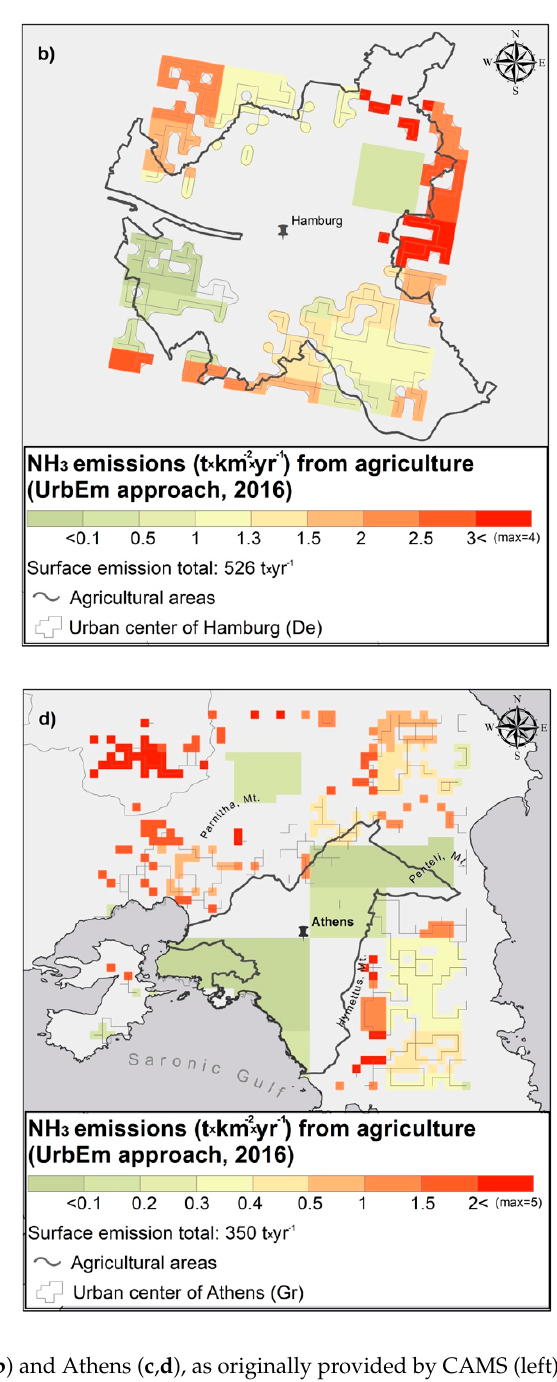
Figure A2. Daily PM 2.5 ( μ g m − 3 ) scatter plots for ( a ) Athens, December 2018 and ( b ) Hamburg, 2016. The observed (obs) versus modeled (mod) mass concentrations are shown, the latter when applying the original CAMS emissions (CAMS no proxy) and high-resolution emissions using the newly developed approach (UrbEm). Reference 1.